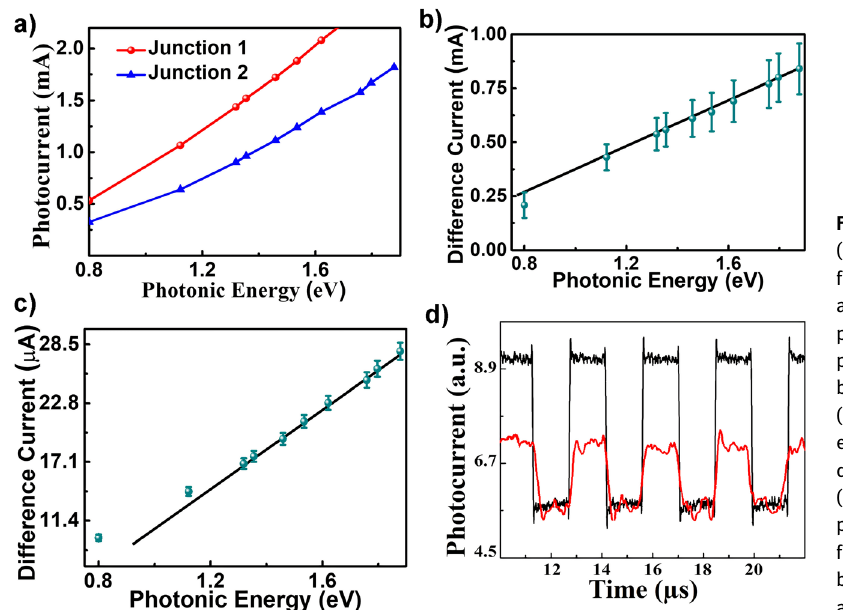
Figure 4: Frequency response of the